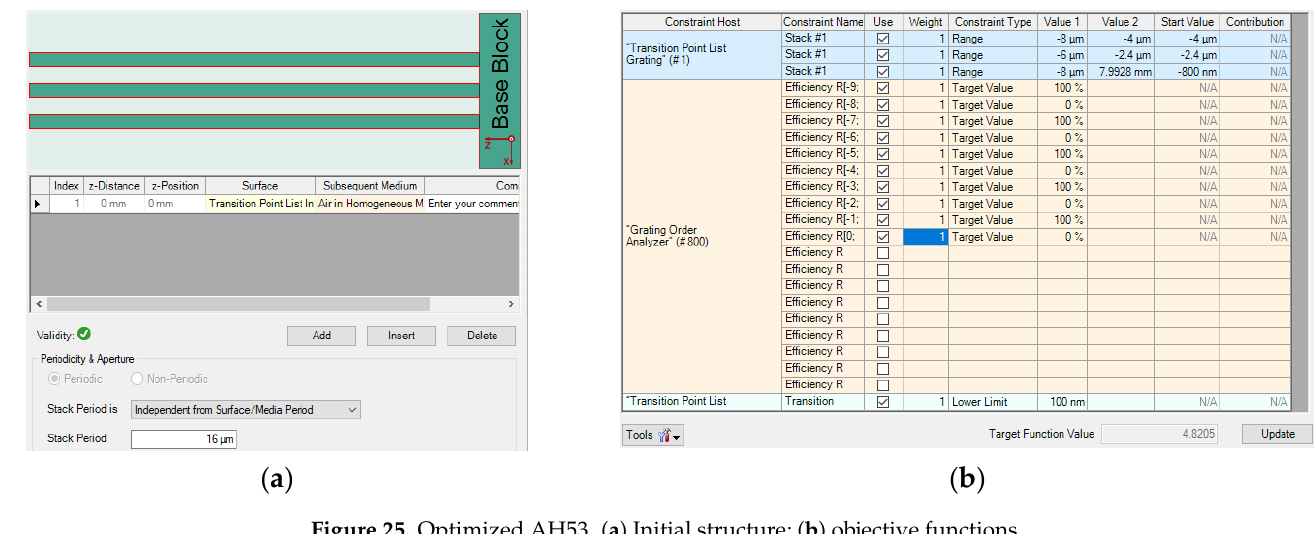
Figure 25. Optimized AH53. ( a ) Initial structure; ( b ) objective functions.